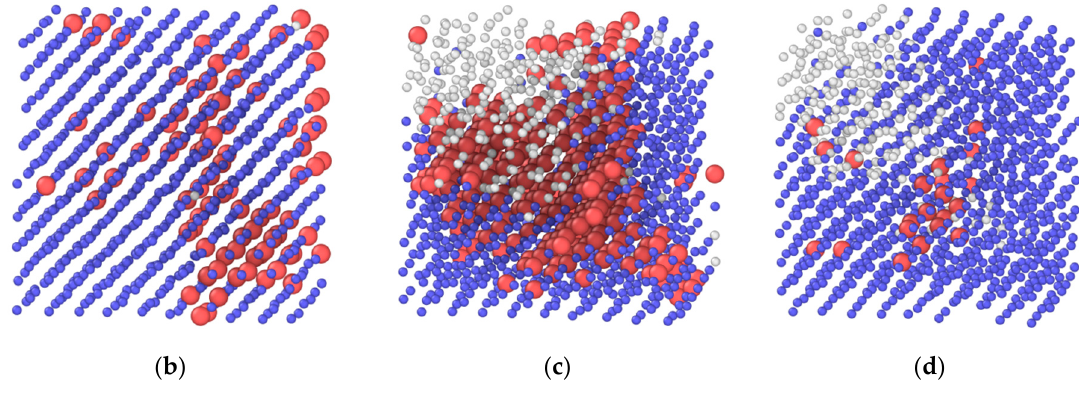
Figure 8. Location and atomic structure of fragment “A” in the β -Ti inclusion containing 13 at. % of vanadium ( a ). The dashed ovals indicate vanadium-enriched domains. Evolution of the atomic structure of the fragment at scratch lengths of 2 ( b ), 25 ( c ) and 35 nm ( d ). According to CNA [37], the HCP atoms are shown red, BCC atoms are shown in blue, and atoms belonging to unidentified lattice structures are shown in grey. For clarity, HCP atoms are shown as larger spheres.